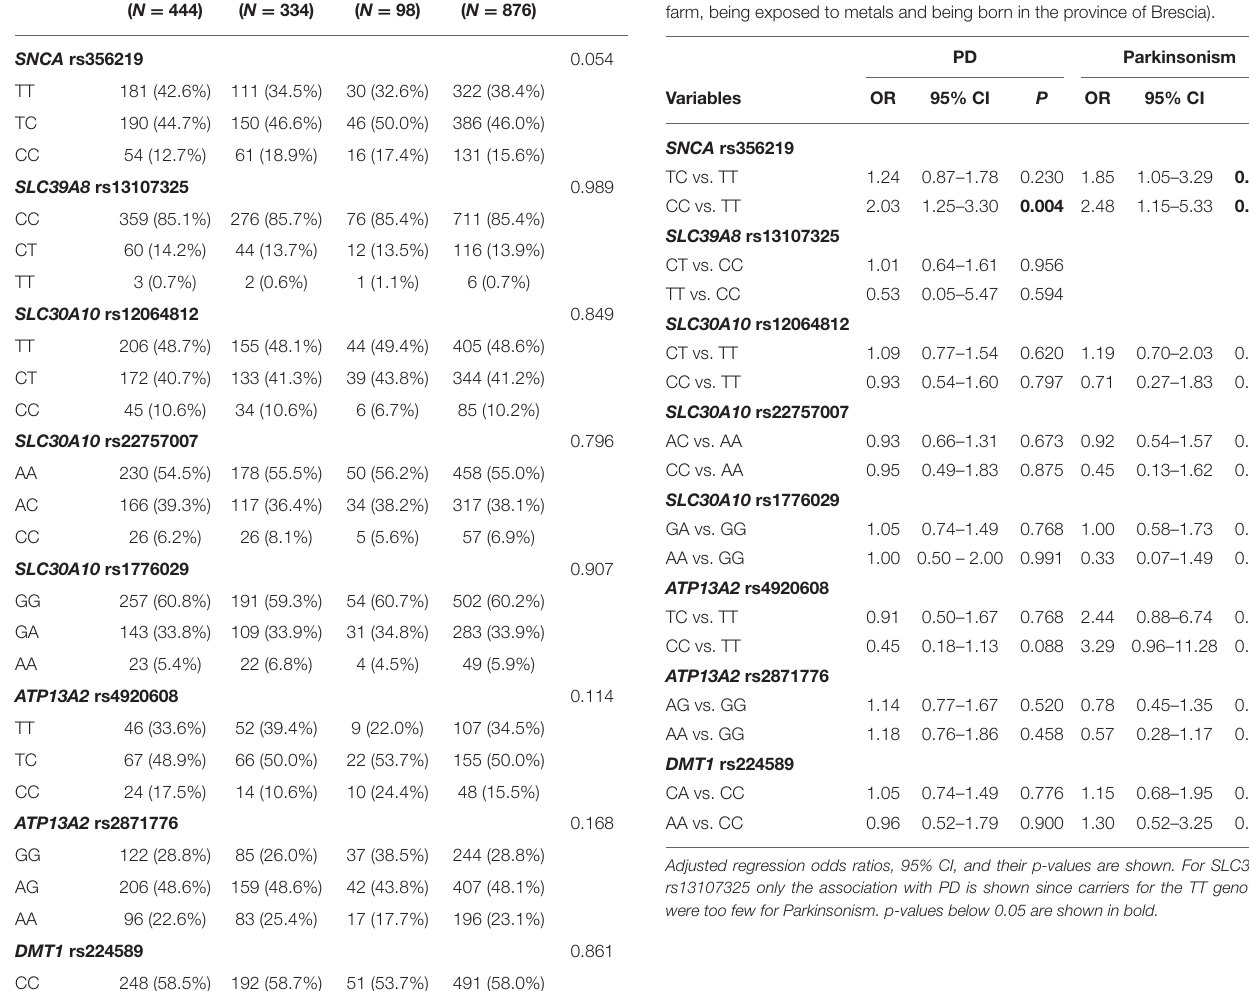
TABLE 2 | SNP frequency among cases and controls. TABLE 3 | Results of multinomial regression analysis to test for the association between each polymorphism and PD and Parkinsonism adjusting for all the risk factors (age, gender, smoking status, PD or tremor familiarity, being born in a farm, being exposed to metals and being born in the province of Brescia).